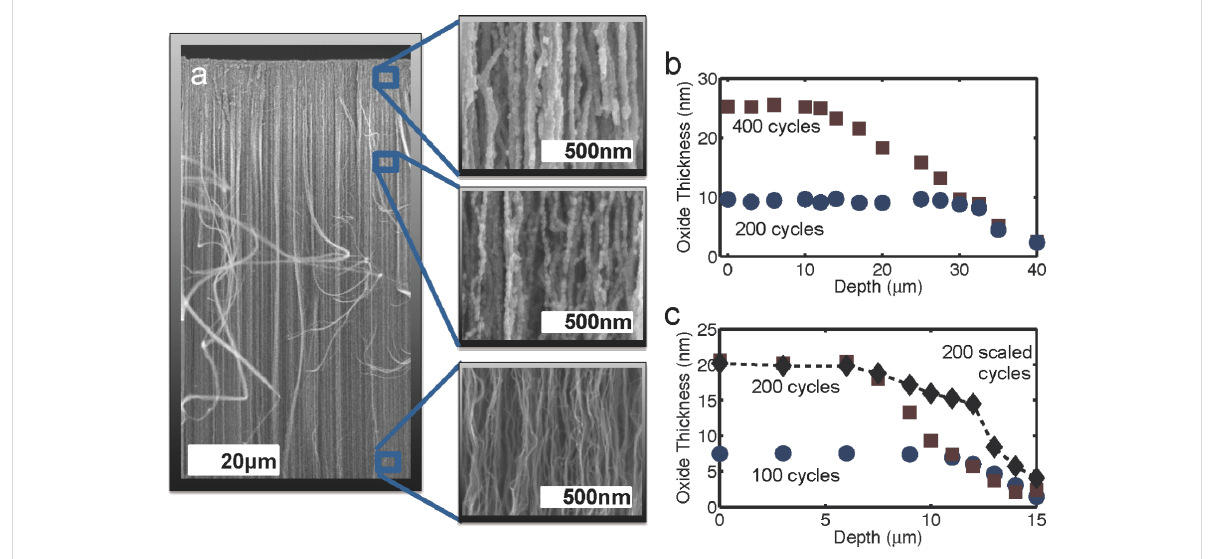
Figure 6: Experimental results for TiO 2 coated VACNTs. (a) An SEM image of a VACNT array coated with 400 cycles of TiO 2 is shown with close-up SEM images at depths of ca. 5, 25, and 80 μ m. At 5 μ m, a thick and conformal coating of TiO 2 is evident. At 25 μ m the oxide coating is visibly thinner, and exposed CNTs are visible, at which the oxide beads have not merged, yet. Down at approx. 80 μ m, only small nucleations of the oxide are notice- able. The TiO 2 thickness on the CNTs (determined by the measurement of the coated-CNT diameter distribution) as a function of depth is plotted in (b) for samples coated with 200 (circles) and 400 (squares) cycles. Error bars are indicated by the size of the points. Plot (c) shows the thickness of aluminum dioxide as a function of depth for the samples prepared with 100 cycles (blue circles) and 200 cycles (red squares), for which the precursor exposure time was fixed at 0.2 s, along with a plot for a sample prepared where the precursor exposure time was scaled as a function of ALD cycles between the 100th and 200th cycles (black